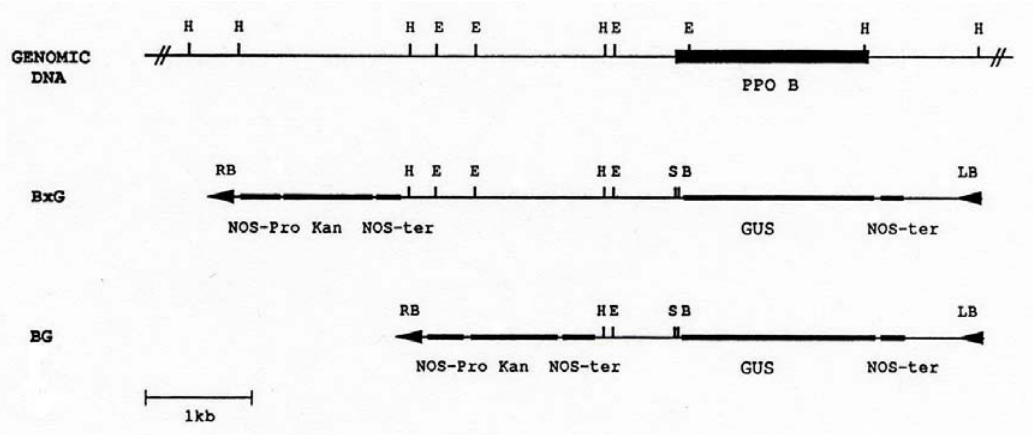
Sma I; B, Bam HI; GUS , β -glucuronidase; Kan, kanamycin; LB, left border; RB,